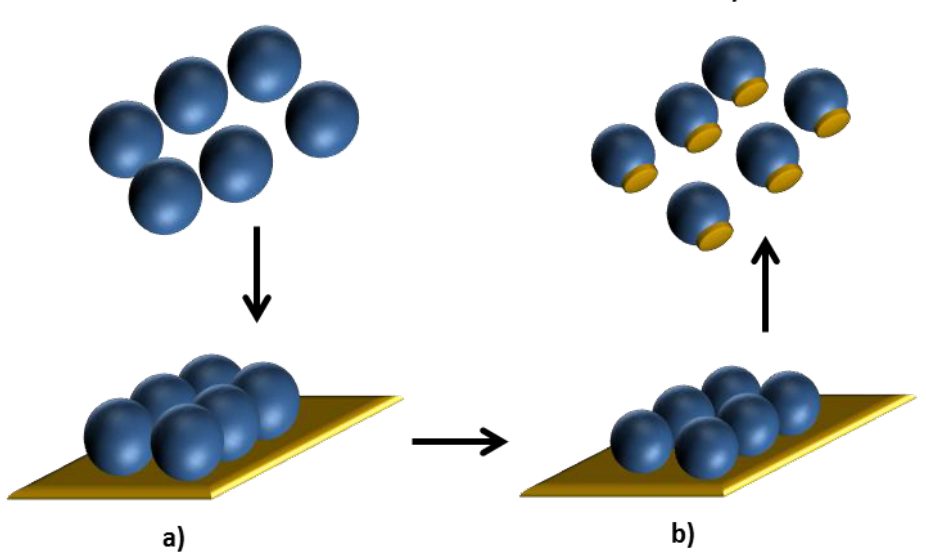
Figure 11. Hybrid polystyrene/gold nanoparticles prepared by: ( a ) adhesion of the particles on Au layer; ( b ) size reduction by plasma etc hing; ( c ) release from substrate. Self-drawn scheme based on the strategy reported in